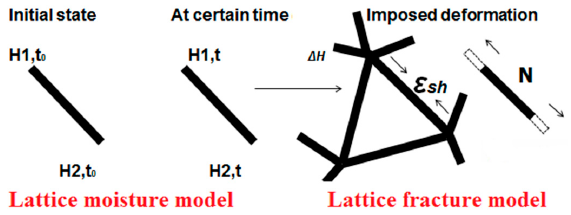
Figure 6. Coupling lattice moisture and lattice fracture model in time ( H -relative humidity).